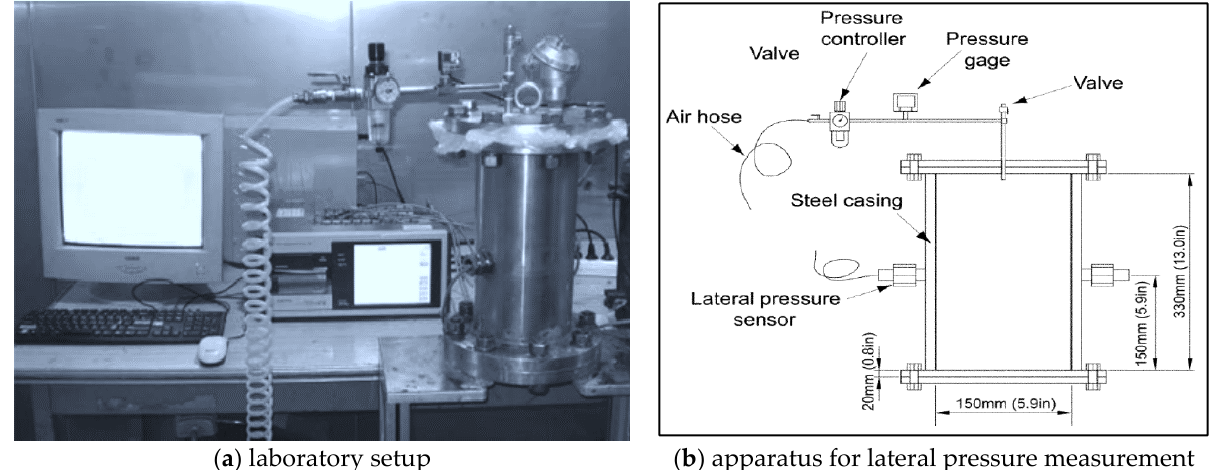
Figure 5. Laboratory setups for lateral pressure measurement (reprinted from [74], with permission © John Wiley and Sons).